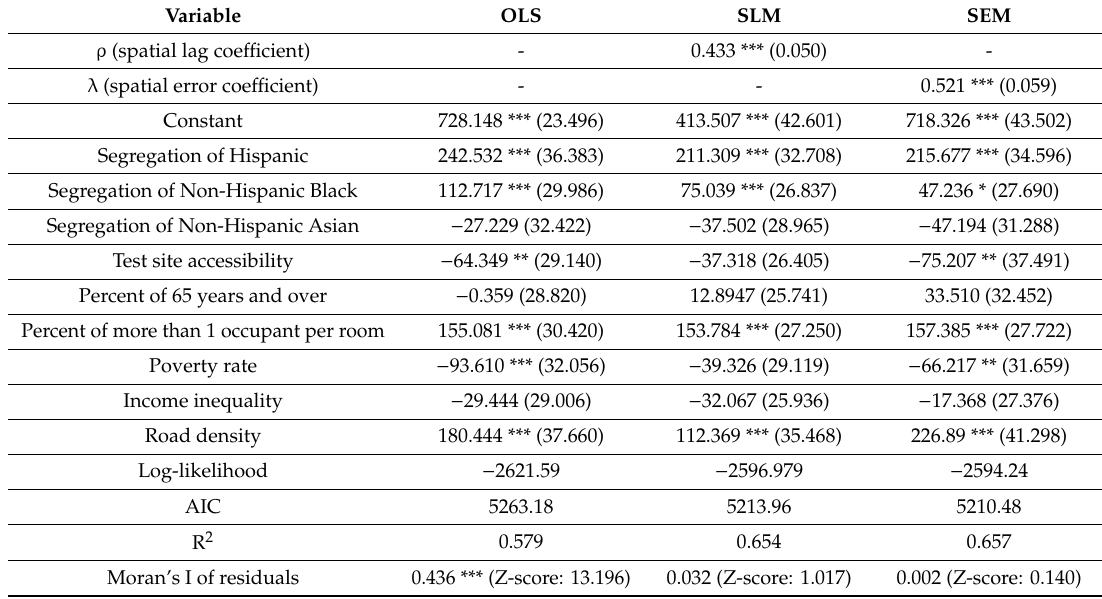
Table 3. Results of regression models at town / city